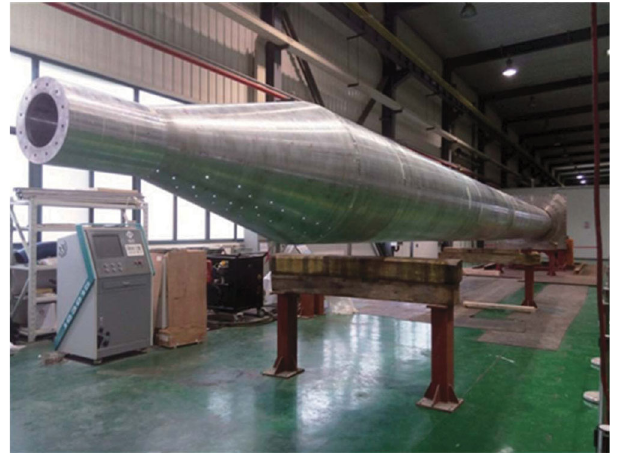
FIG. 20. The stalk cantilever after the assembling was finished. The stalk was only fixed to a replaced base at the furthest end. and positioning